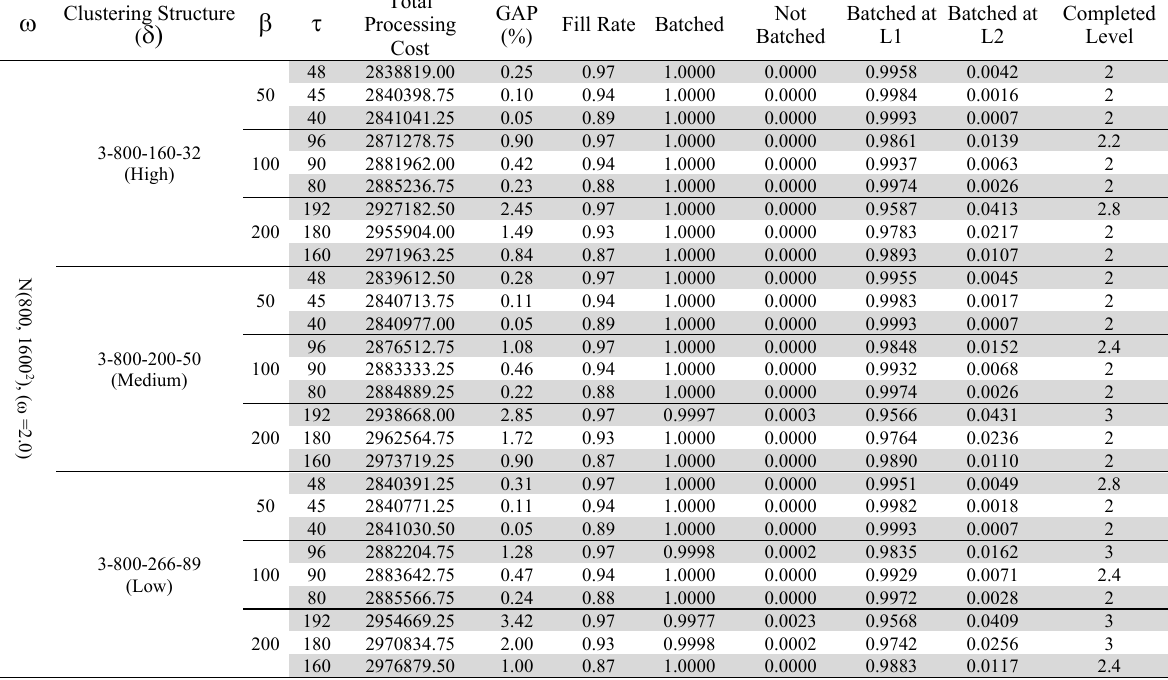
Results for demand scenario S-27 with 3-Level non-exclusive